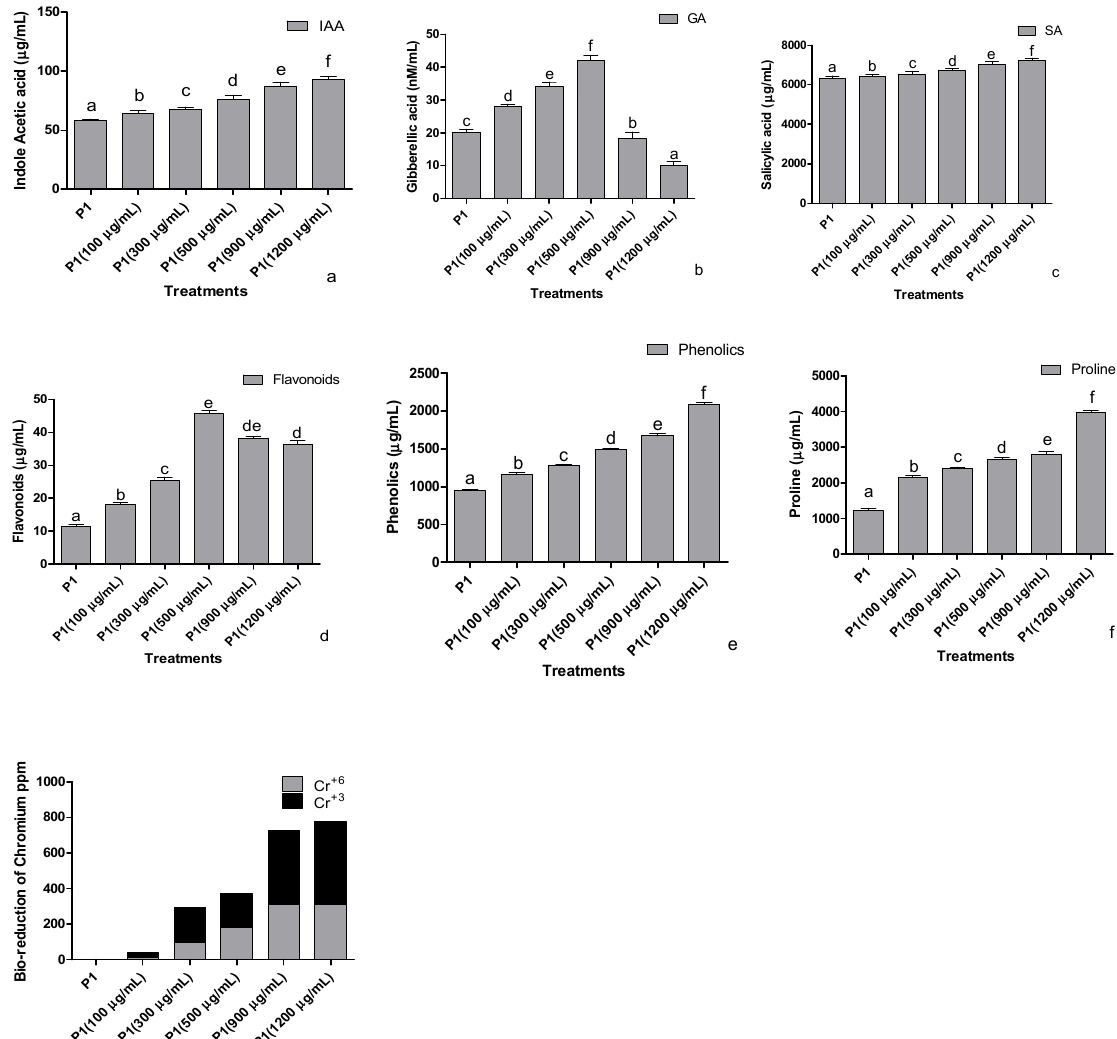
Figure 2. Effect of chromate stress on the concentration of ( a ) indole acetic acid, ( b ) gibberellic acid, ( c ) salicylic acid, ( d ) flavonoids, ( e ) phenolics, and ( f ) proline in the bacterial culture supernatant and ( g ) bioreduction capability of the rhizobacterium P1. The rhizobacterium was grown in the LB broth containing different quantities of hexavalent chromium for 24 h, and the supernatant was then assessed for the mentioned parameters. Data are means of nine replicates with ± SE of the mean. Different alphabets represent significance ( p < 0.05).